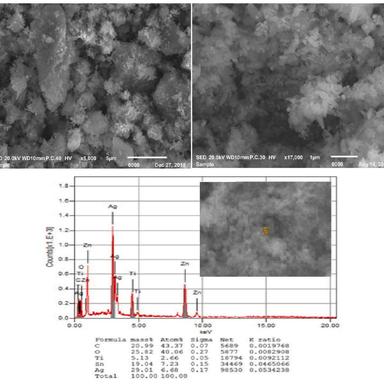
Scanning electron microscopy micrograph (upper) of GO@TiO2.ZnO.Ag and EDX analysis (down) .